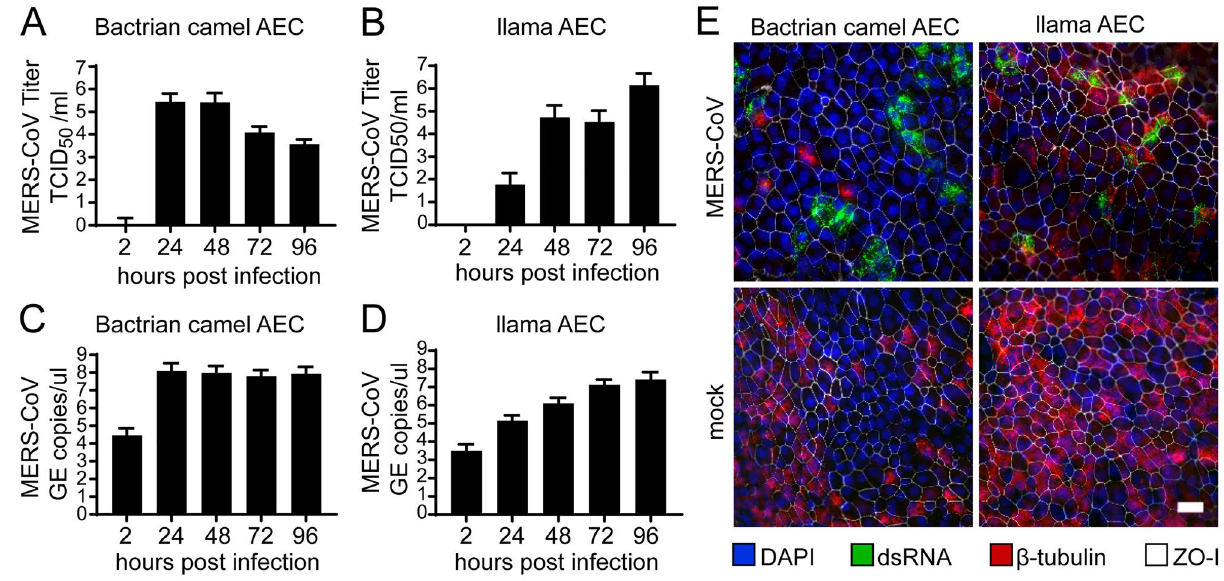
Figure 2. Efficient MERS-CoV replication in camelid AEC cultures. MERS-CoV titer in TCID 50 /ml released from camel ( A ) and llama ( B ) AEC cultures’ apical side from 24 to 96 h post-infection depicted in a log10 scale. Apical virus release in Bactrian camel ( C ) and llama ( D ) AEC cultures measured by quantitative reverse transcription PCR. Data is shown as means and standard deviation from three ( A,C ) or six ( B,D ) independent biological replicates. ( E ) Representative immunofluorescence staining of MERS-CoV-infected camel and llama AEC cultures at 48 post-infection. Double-stranded RNA is shown in green, β-tubulin in red, ZO-I in white and DAPI in blue. Scale bar is 20